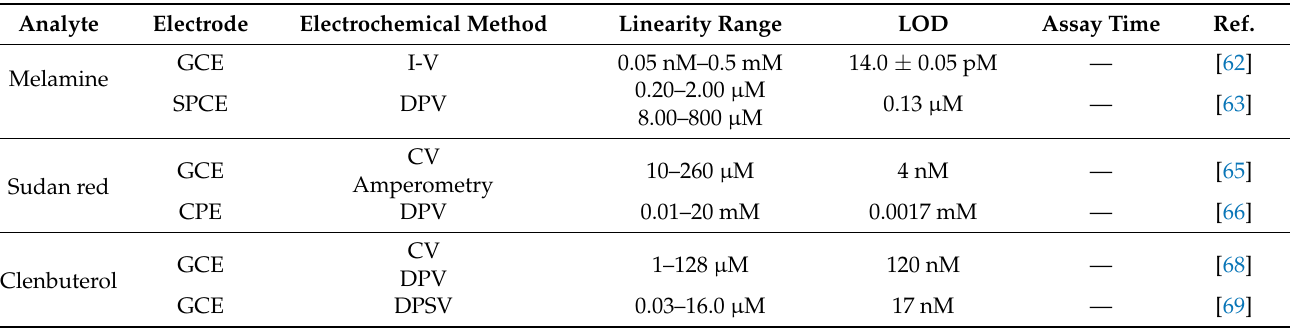
Table 7. Electrochemical biosensors for the detection of illicit additives.